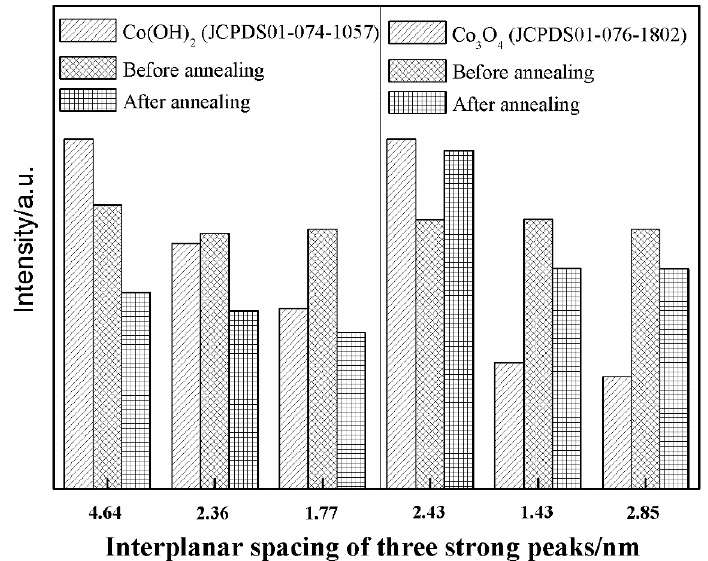
Figure 6. Change in intensity of three strong peaks related to Co(OH) 2 and Co 3 O 4 before and after annealing.